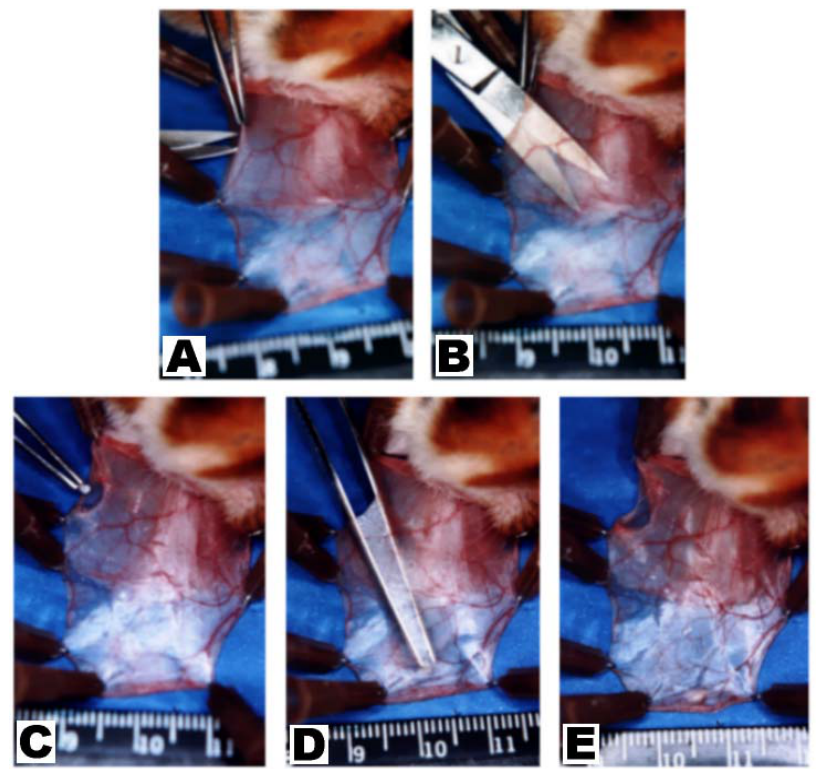
FIGURE 3 – Technique of grafting on hamster cheek pouch